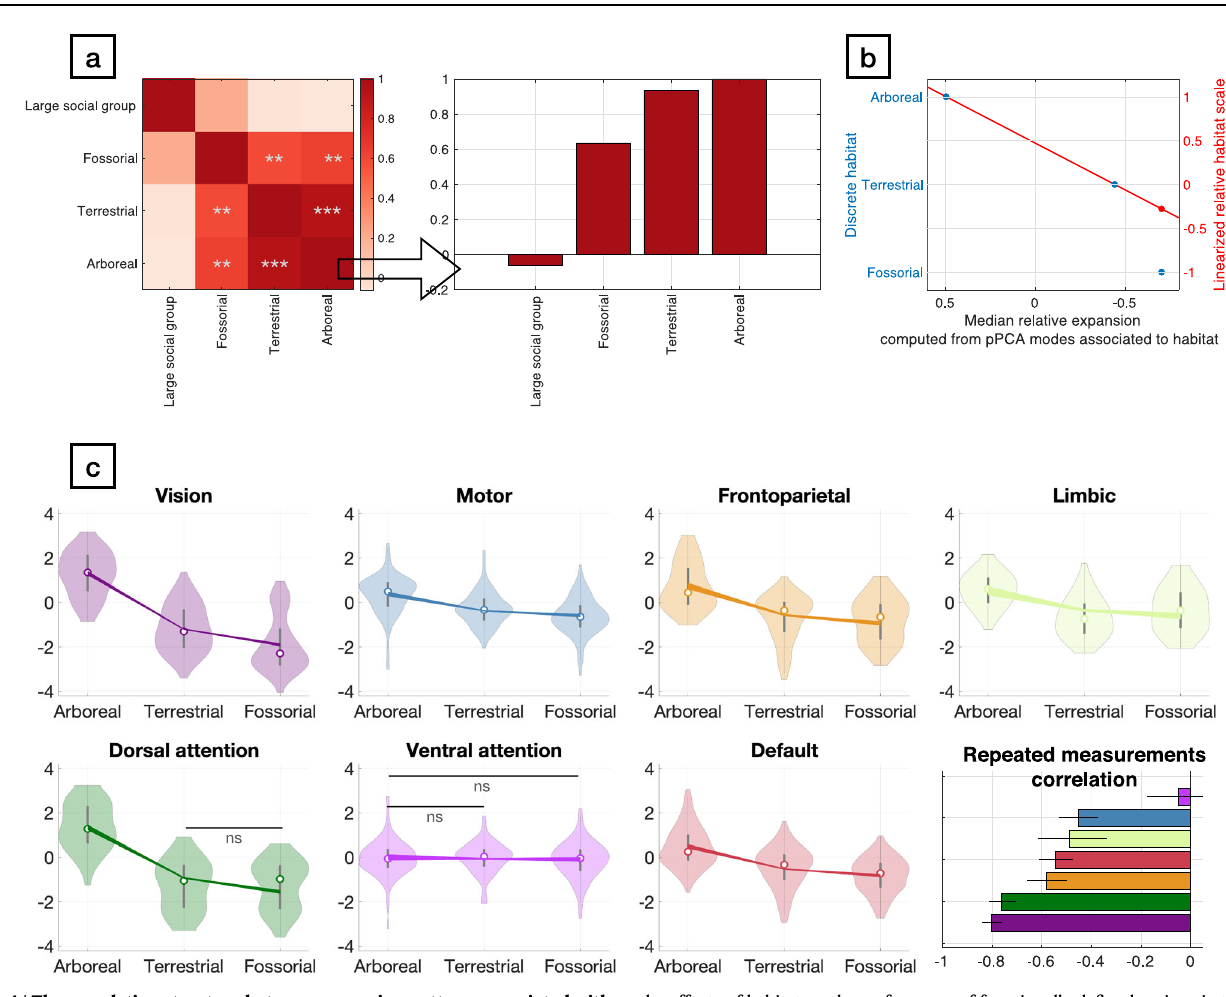
the effects of habitat on the surface area of functionally de fi ned regions in the cerebral cortex revealed a putative ordering related to habitat complexity. Violin plots of the distribution of local expansion values in each region for each map associated with a speci fi c habitat are shown together with median values and fi rst and last quartile+/ − 1.5 interquartile range (IQR), as well as 95% percentiles of the output of the repeated measurements correlation model of the same values. The dorsal attention areas for terrestrial and fossorial and the ventral attention regions for arboreal and terrestrial species were the only regions showing no signi fi cant (two-tailed Friedman test) effects in terms of relative expansion, while the limbic areas where the only ones to show signi fi cant relative expansion in association to fossoriality(r=0.628, p <1e-6,95%CI=[0.584,0.671],FDR-corrected).Allstatistical information is available in Supplementary Data 4b). Repeated measurement corre- lation analysis (shown as predicted correlation for each functionally de fi ned region together with 95% con fi dence intervals) corroborated this result by indicating non- signi fi cant effects only for the ventral attention network (Supplementary Data